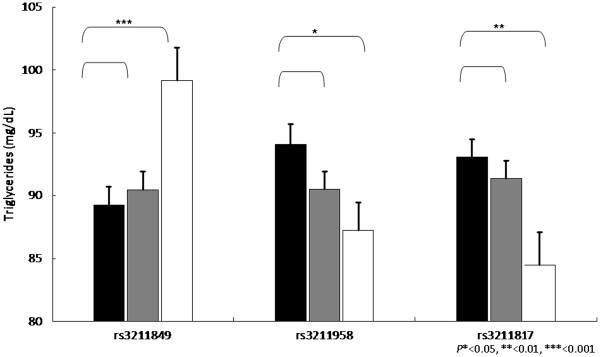
Impact of CD36 gene on triglycerides levels (mg/dL ± SE) from pairwise genotype comparisons. Adjusted mean triglycerides for non-carriers (black bars), for heterozygous (gray bars) and subjects homozygous for the minor allele (white bars). Sample sizes (n for non-carriers, heterozygous, and homozygous subjects for SNP (rs3211849), n = 383, 408, 119, for SNP (rs3211958), n = 305, 432, 174, and for SNPs (rs3211817) n = 377, 416, 115, resulting co-dominant P-values as 0.004, 0.035, and 0.018.